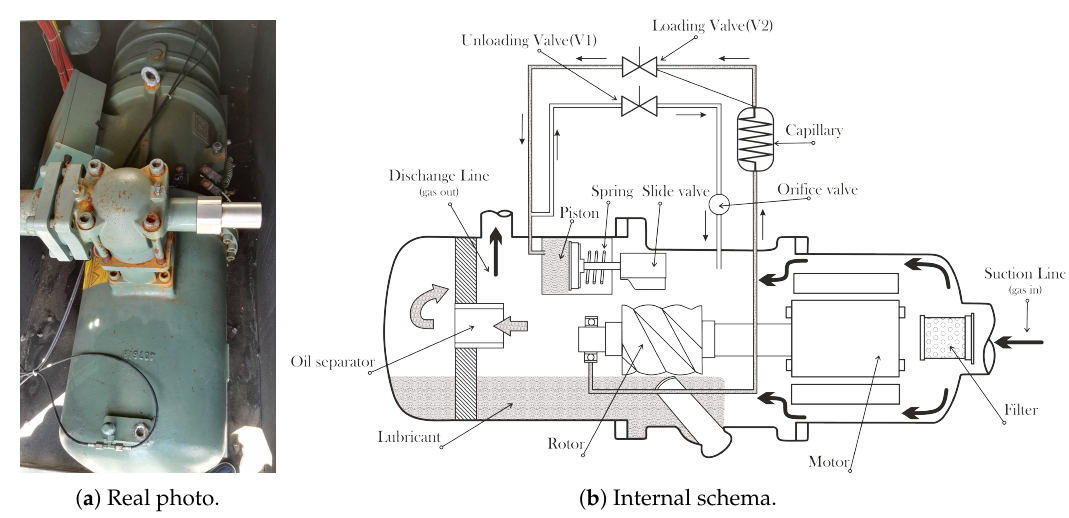
Figure 3. A screw compressor of the air-cooled chillers.